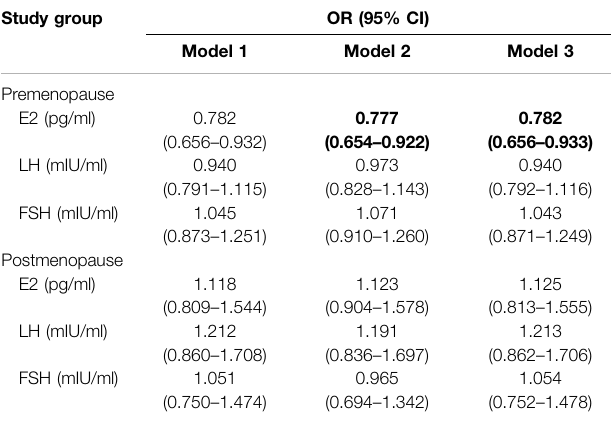
TABLE 3 | Association of DILI with estrogen levels (per one standard deviation) in premenopausal and postmenopausal patients with breast